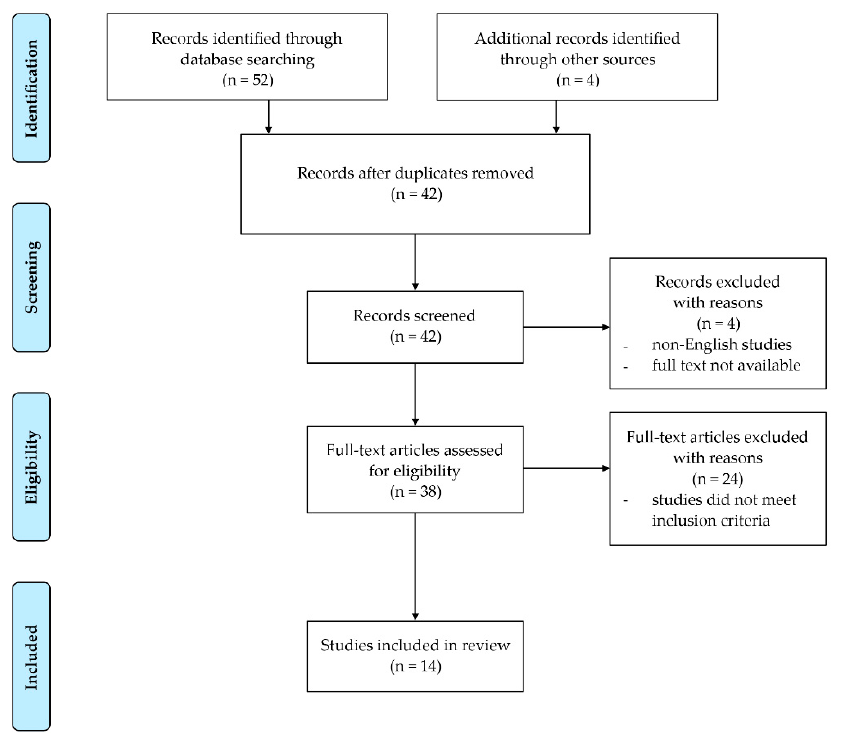
Figure 1. PRISMA flow diagram [14].